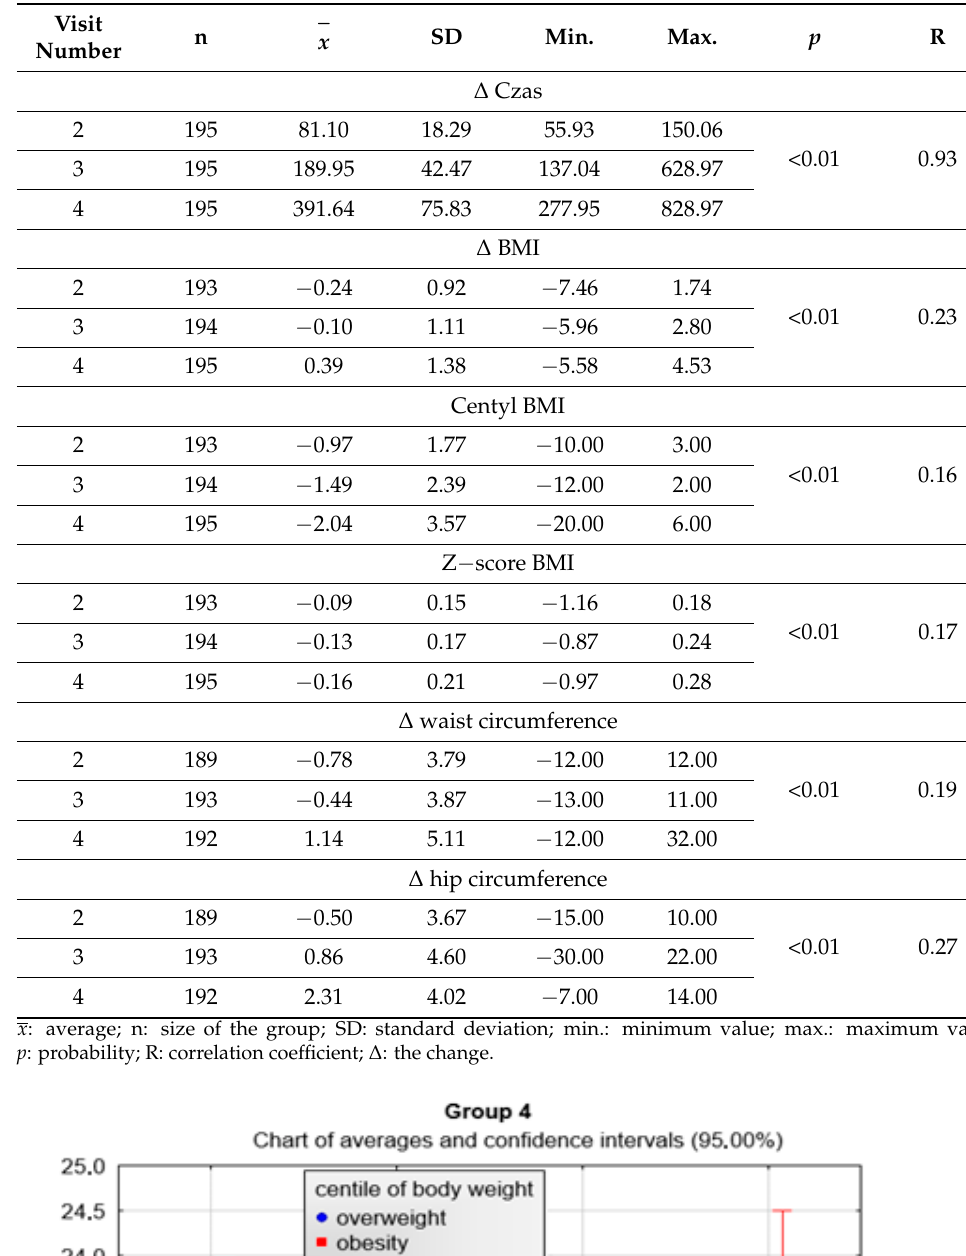
Table 8. Change in anthropometric parameters in group 4.